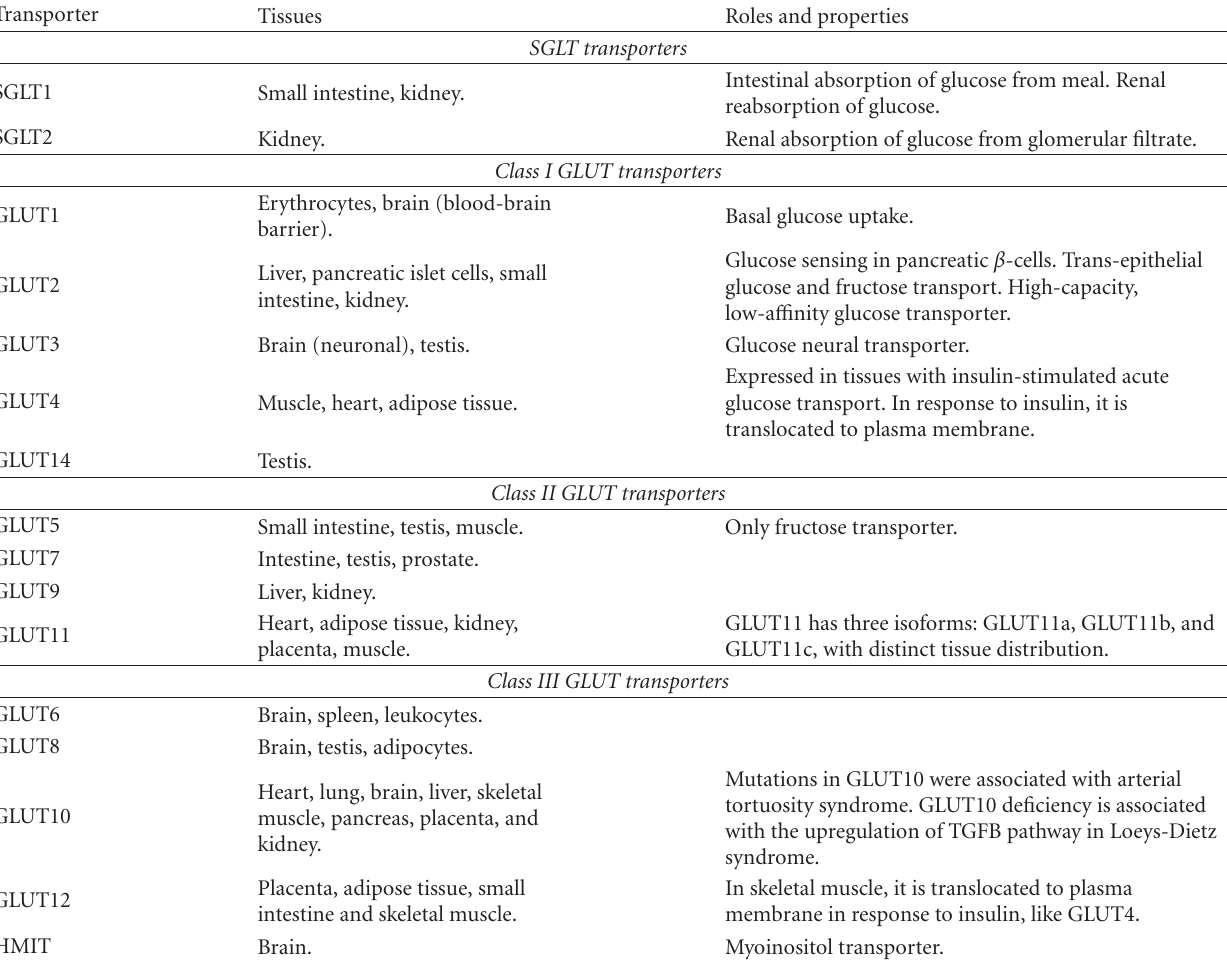
Table 2: Sugar transporters and their expression in